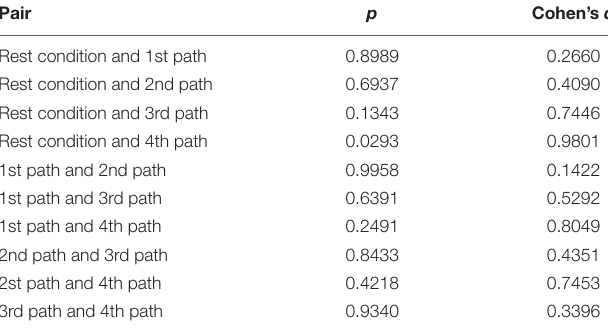
TABLE 2 | Comparing the fractal exponent of HRV.